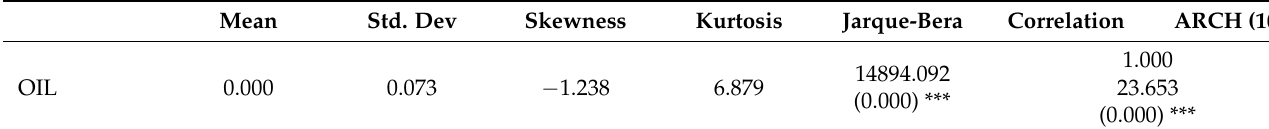
Table 1. Descriptions of data statistics.